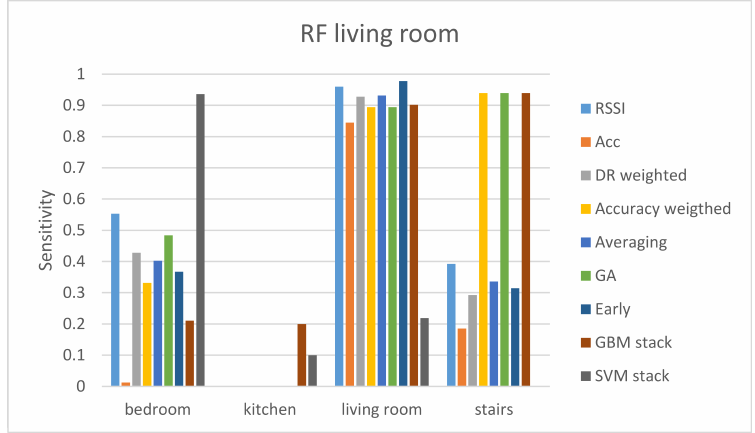
Figure 2. Sensitivity results of the RF classifier for the living room